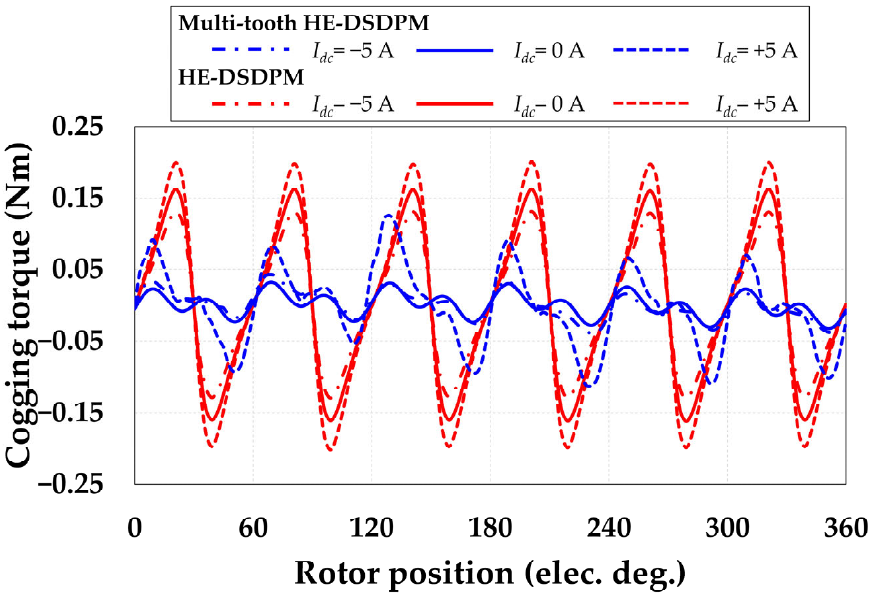
Figure 9. Cogging torque of the proposed HE-DSDPM with various I dc . Figure 10a indicates the electromagnetic torque of the multi ‐ tooth and conventional